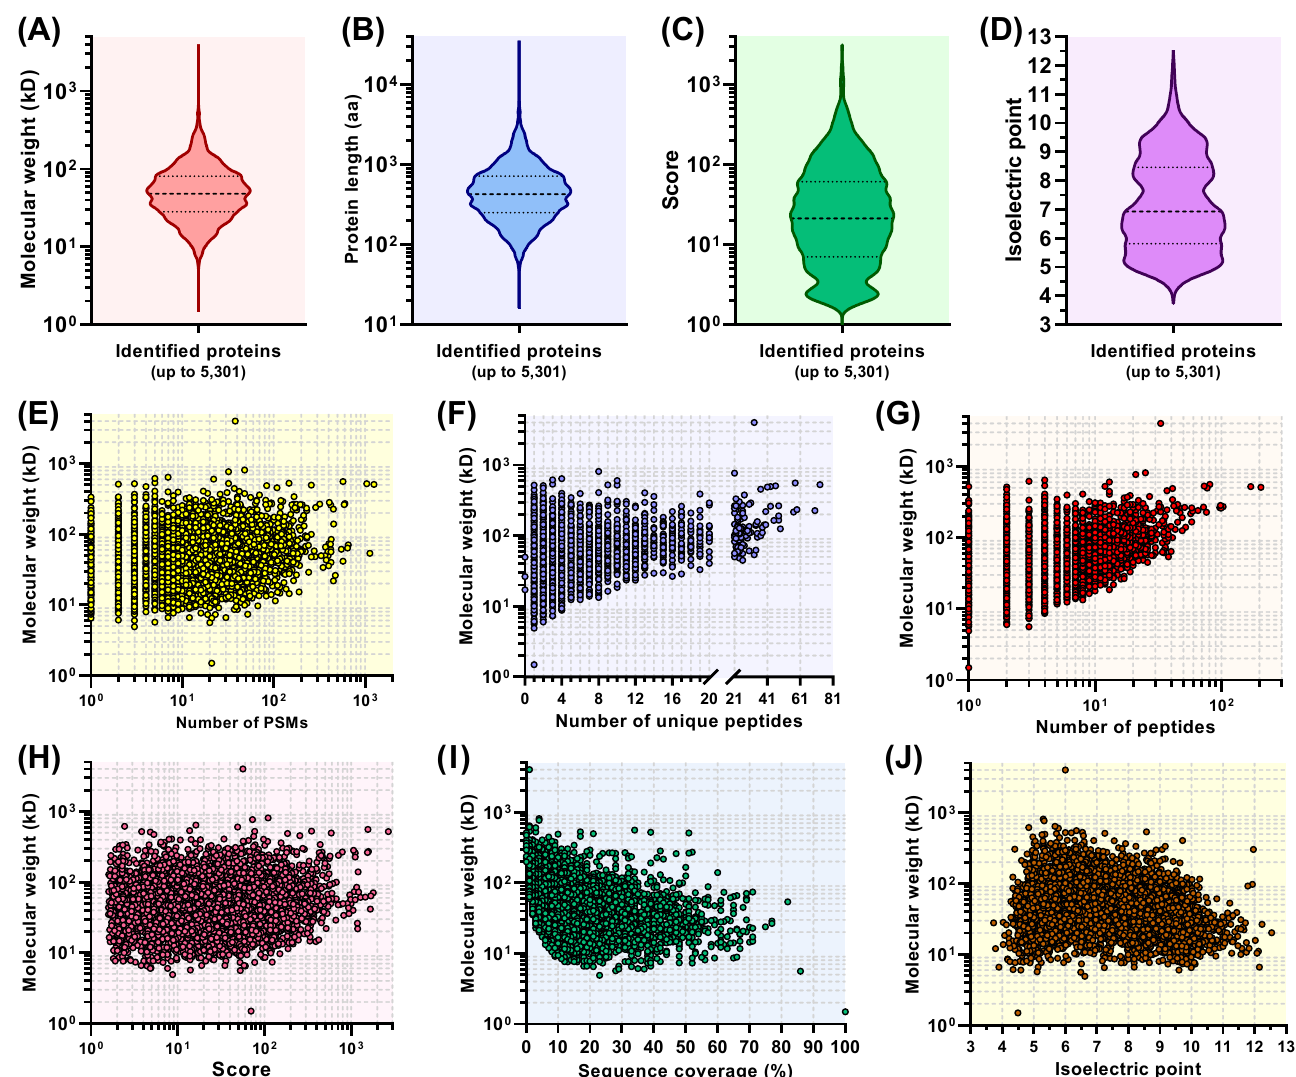
Figure 2. Comprehensive proteomic profiling of six groups. Violin plot-exhibited distributions of molecular weight ( A ), protein length ( B ), score ( C ) and isoelectric point ( D ) for all 5301 identified proteins. Corresponding relations between the molecular weight and the number of PSMs ( E ), the number of unique peptides ( F ), the number of peptides ( G ), score ( H ), sequence coverage ( I ) and isoelectric point ( J ) for each identified